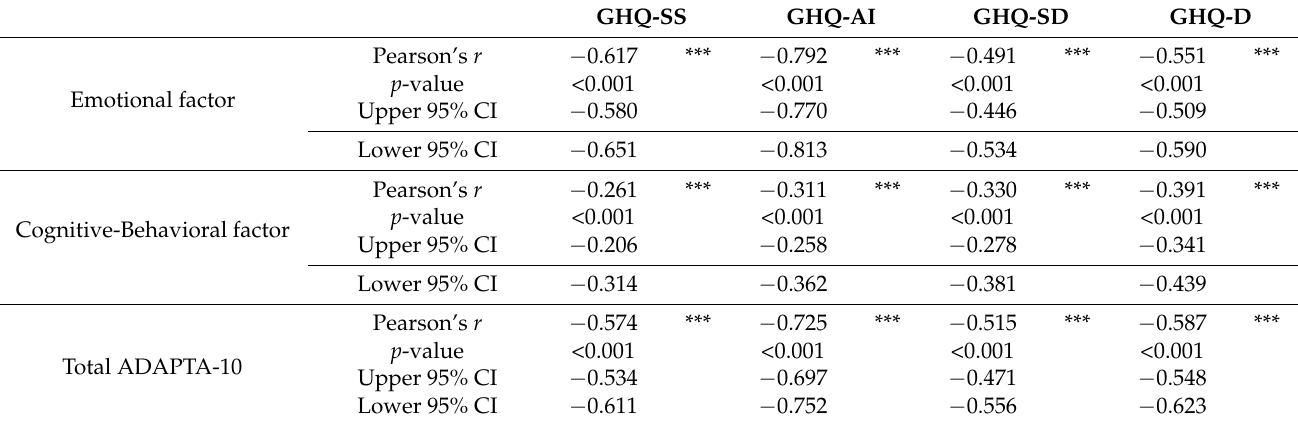
Table 2. Adaptation to change and health. Pearson correlations.